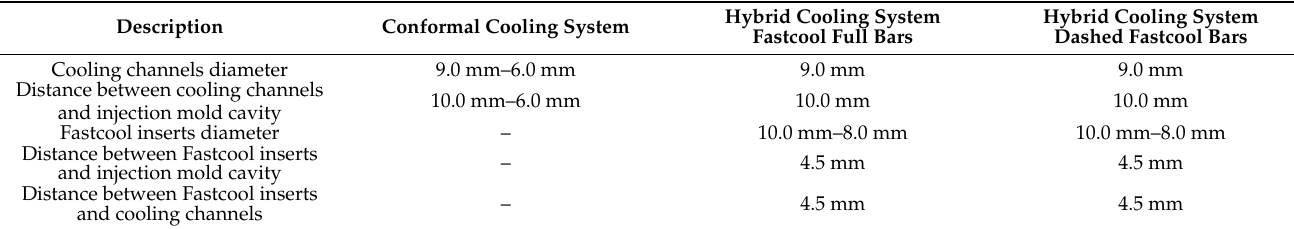
Table 7. Geometric variables of the traditional cooling system